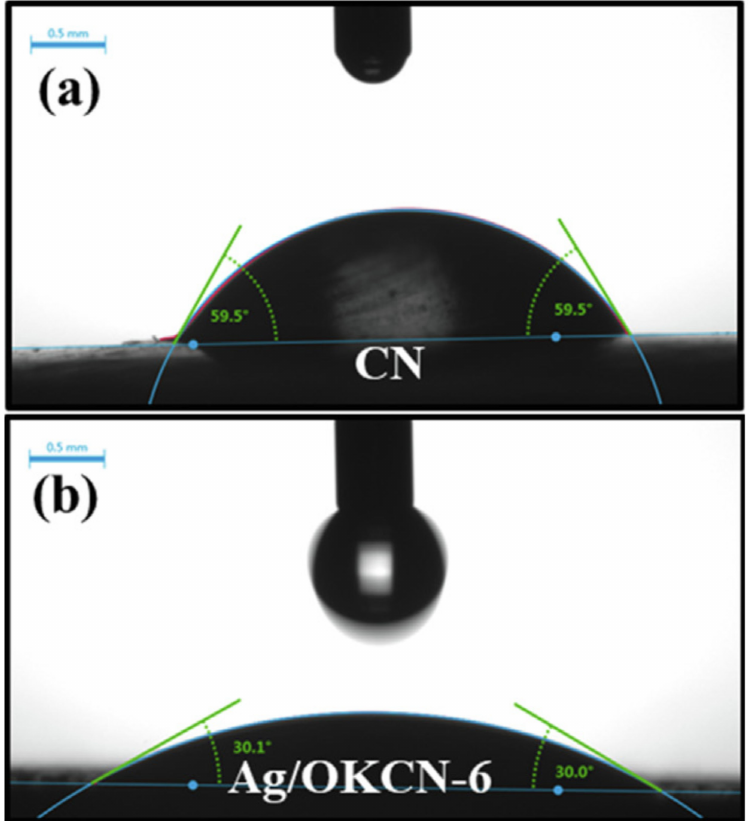
Figure 11. The contact angle of ( a ) pure GCN, and ( b ) Ag deposited K, O-GCN. Reproduced with permission from Ref.